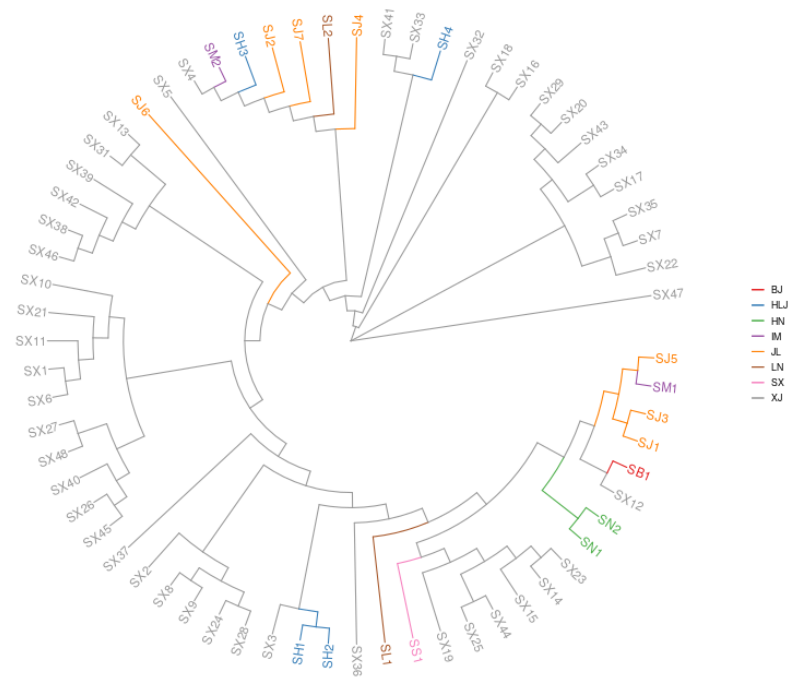
Figure 1. Phylogenetic tree constructed according to the neighbor-joining method with polymorphic SNPs based on 66 S. nigrum individuals. The colors of branches indicate genotypes corresponding to different sub-origin sets. BJ: Beijing; HLJ: Heilongjiang, HN: Henan, IM: Inner Mongolia; JL: Jilin; LN: Liaoning; SX: Shaanxi; XJ: Xinjiang.